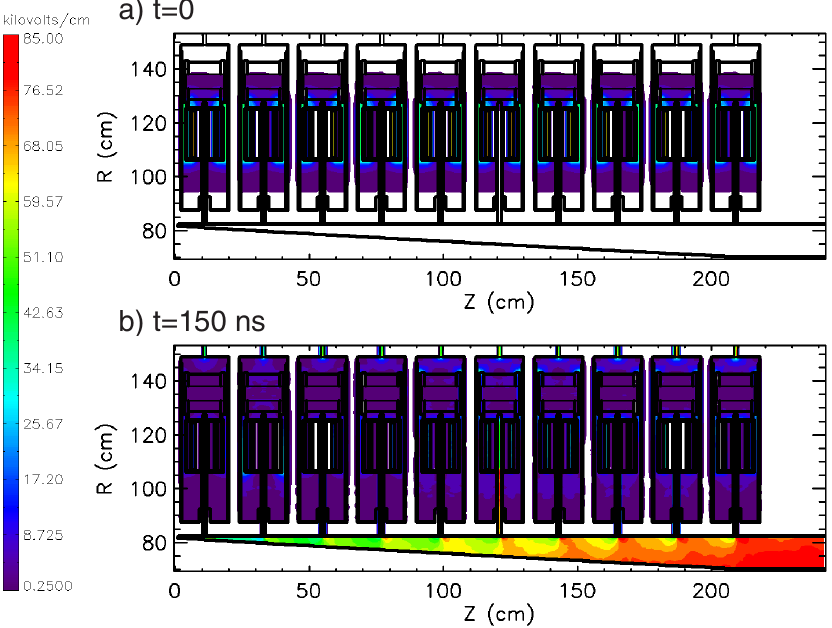
FIG. 7. (Color) Electric field magnitudes from the ten-cavity 3D LSP simulation model at (a) t ¼ 0 and (b) t ¼ 150 ns . The plots show the azimuthal plane passing through the center of the switch and